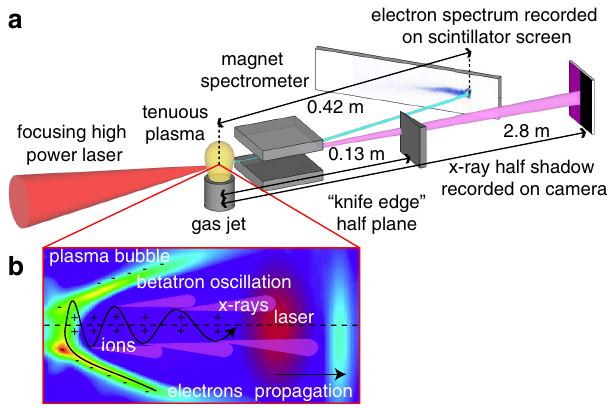
FIG. 1. Schematic of the (a) experimental setup and (b) inside of the plasma